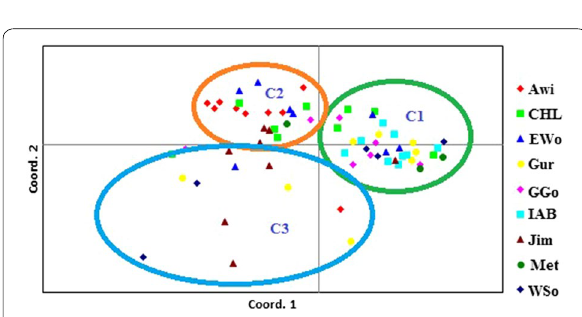
Fig. 5 Two-dimensional PCoA representations of genetic relationships among the 67 P. edulis accessions based on Jaccard’s coefficients of